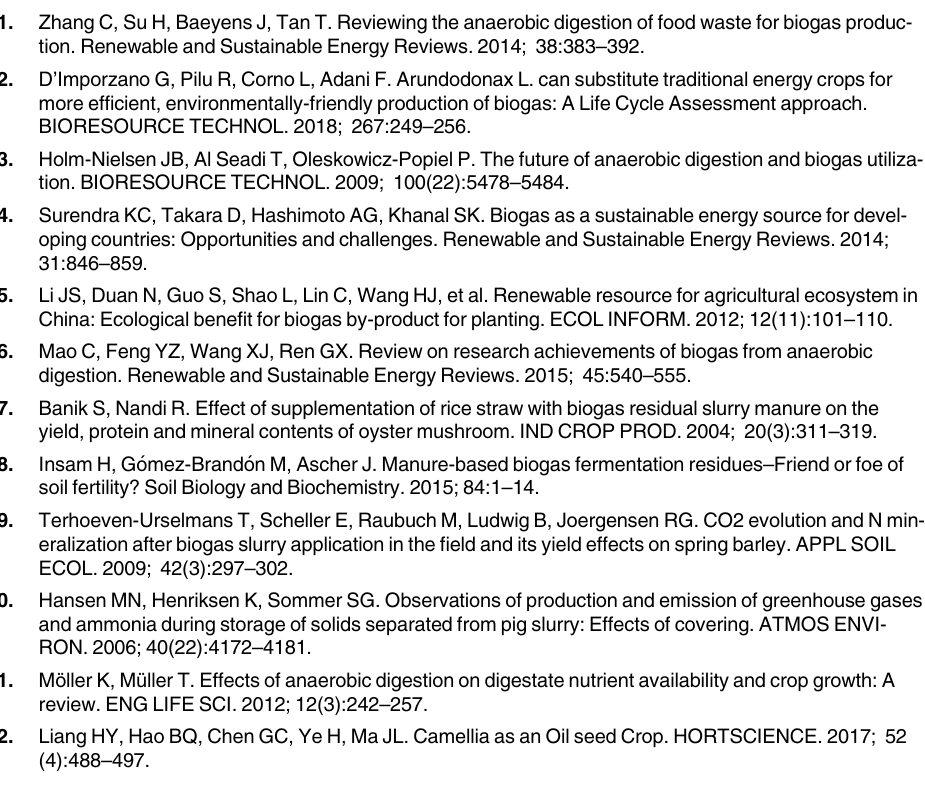
S3 Table. Corresponding raw data of Table 3. S4 Table. Corresponding raw data of Table 4. S5 Table. Corresponding raw data of Table